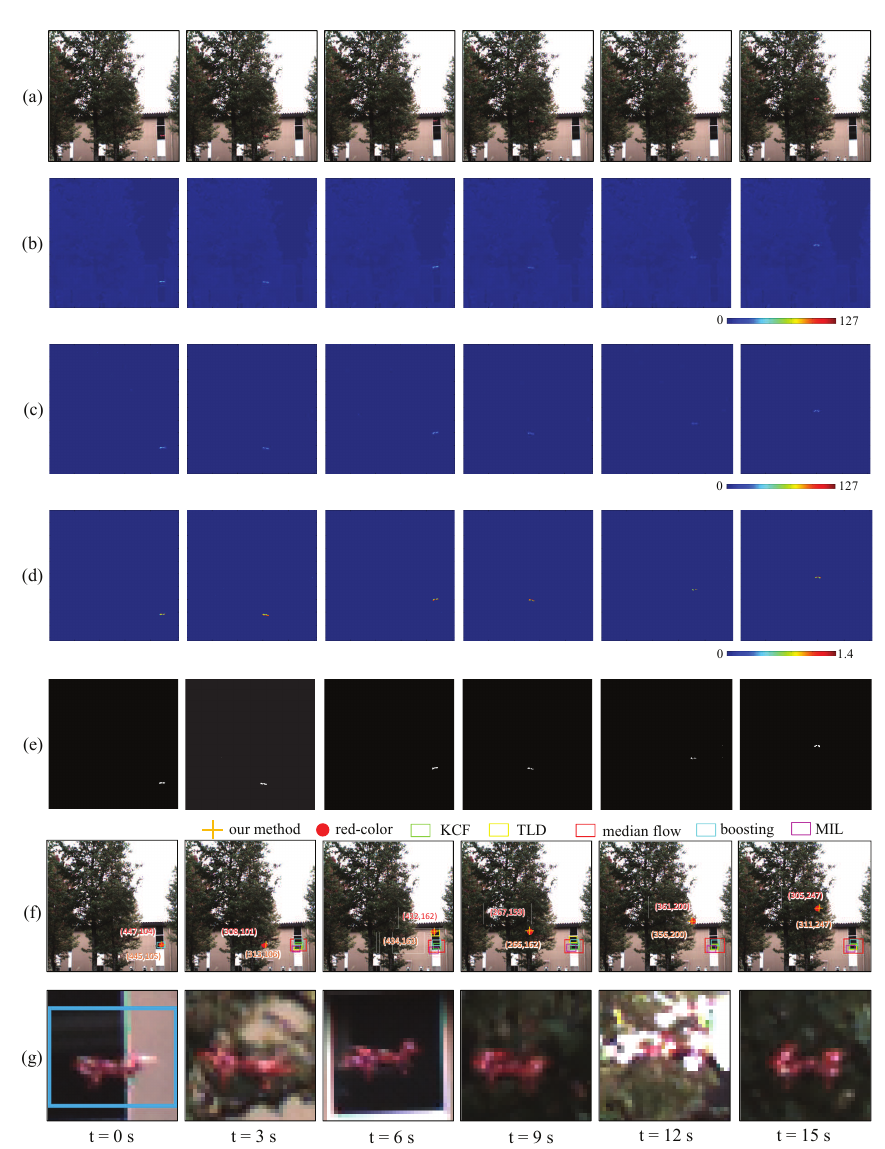
Figure 19. ( a ) Input images; amplitude of ( b ) input; and ( c ) pixel-wise filtered images; ( d ) amplitude ratios; ( e ) extracted vibration features; ( f ) tracked positions; ( g ) magnified